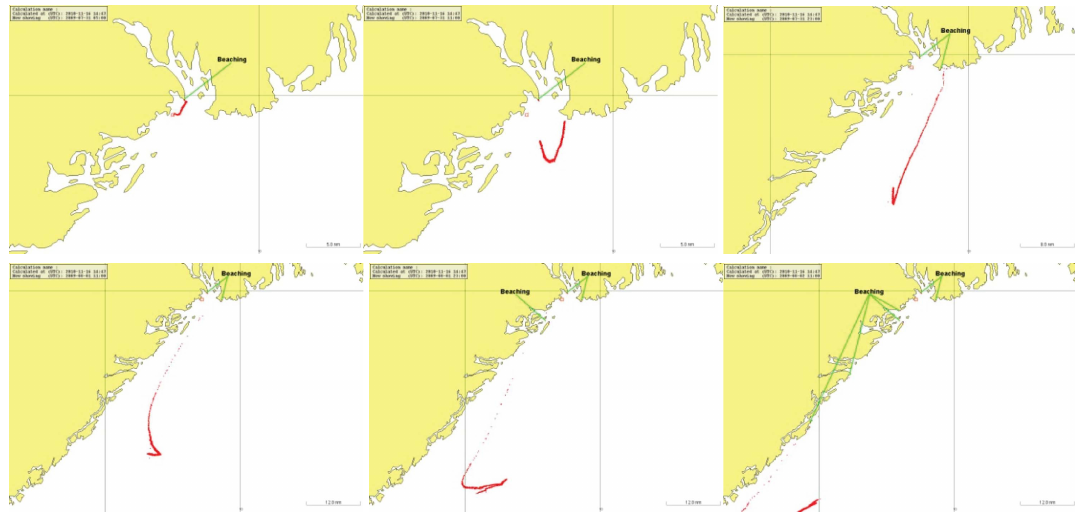
Fig. 10. The Seatrack Web oil drift simulation performed by DAMSA. The figures show the output 6, 12, 24, 36, 48, 60h after the initial release of oil.